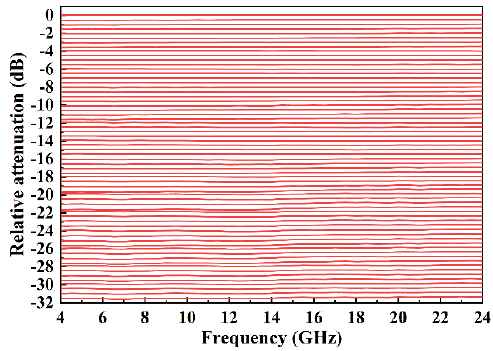
Figure 20. The measured relative attenuation of all states.